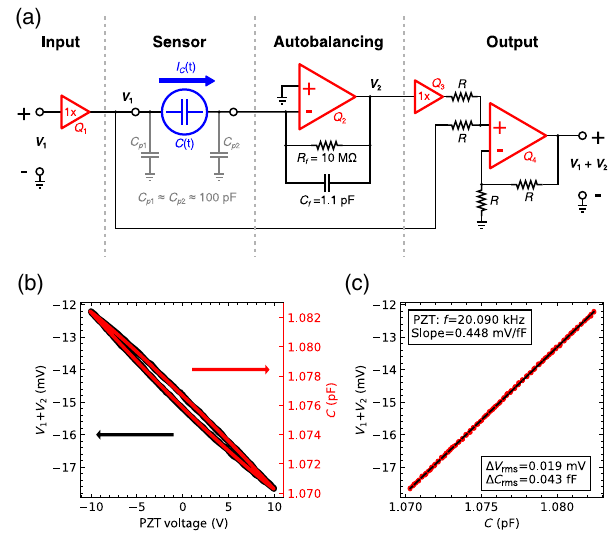
FIG. 10. Construction and calibration of the autobalancing capacitance bridge. (a) Diagram of the circuit employed here. An ≈ 20 kHz reference input sine wave ( V 1 ) is buffered at the input, then applied to one terminal of the displacement sensor through coaxial cables. The opposite terminal is connected to a virtual ground by the autobalancing section, where the feedback capacitor acts as a reference. The output V 2 of the autobalancing bridge will be a sine wave with magnitude proportional to the ratio of the sensor and reference capacitances, but 180° out of phase with the reference. The signals at V 1 and V 2 are added together with a noninverting summing amplifier, and the two will cancel if the sensor and reference capacitances are equal. (b) Output of the capacitance bridge (right-hand axis) overlaid with independent quasistatic measurements made with a com- mercial capacitance bridge. (c) The output voltage plotted against the measured capacitance, demonstrating linear behavior and a sensitivity of 448 μ V = fF and a root-mean-square noise floor of 43 aF. This corresponds to a displacement of approximately 2